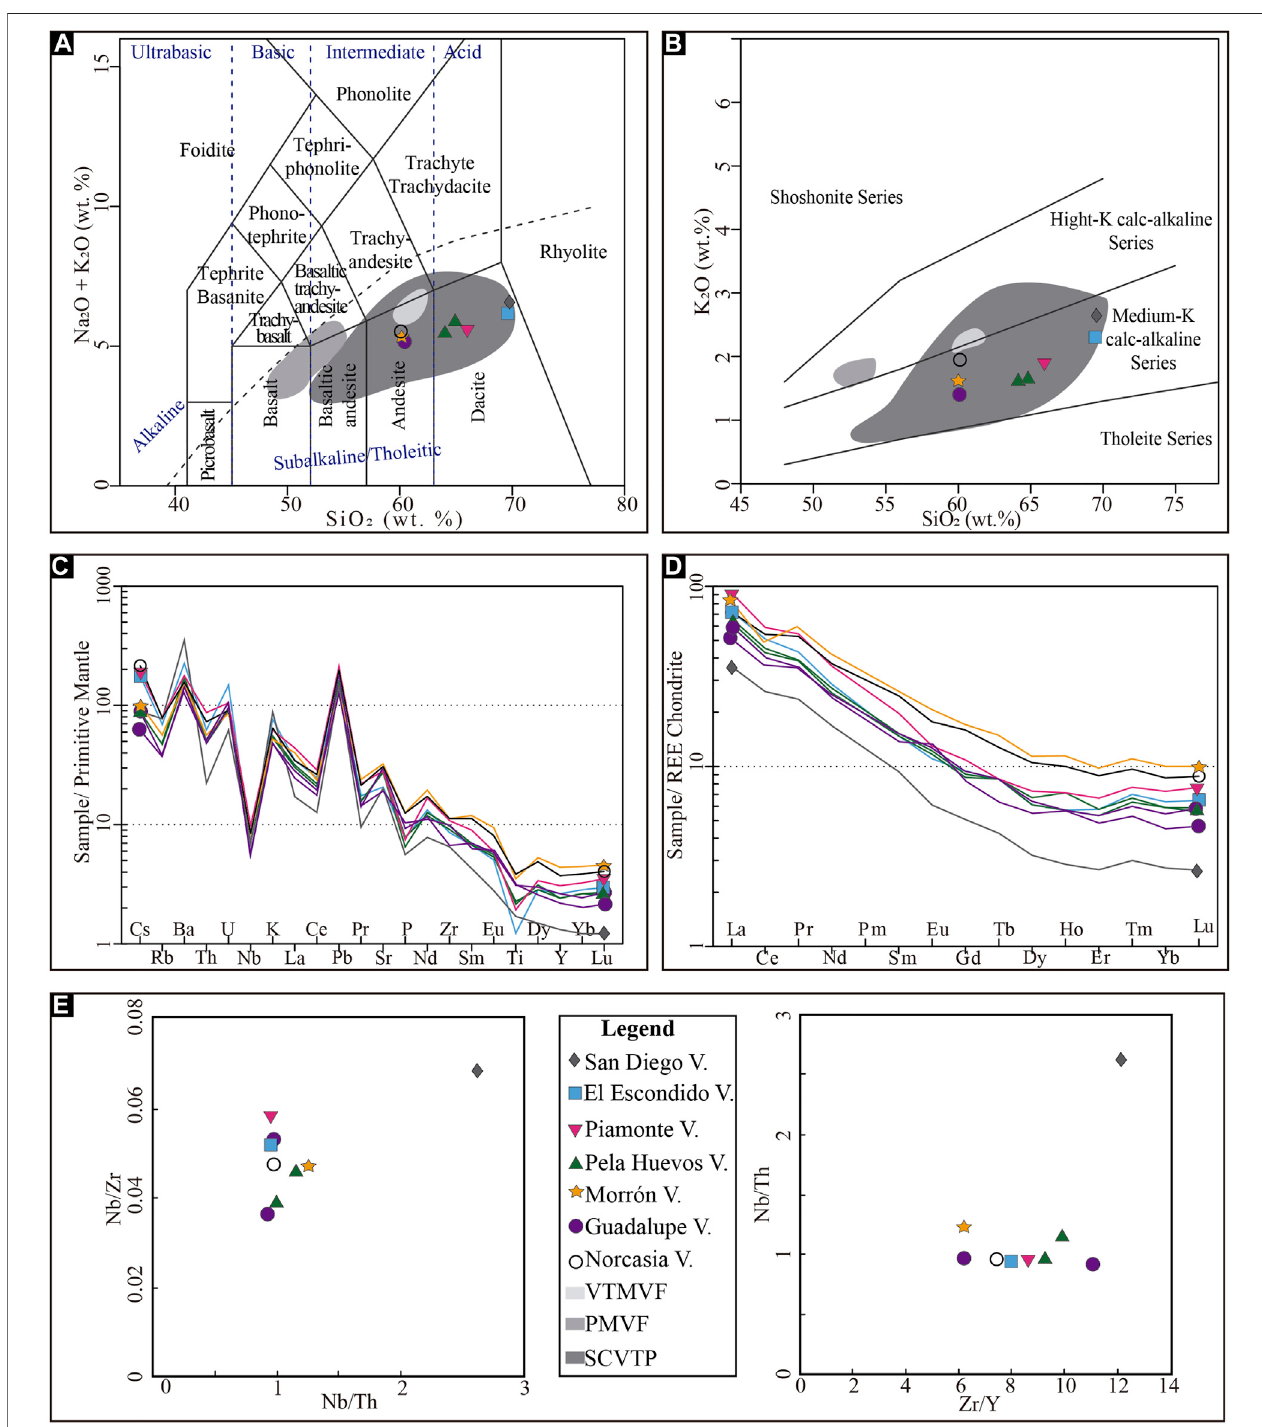
FIGURE 6 | Whole-rock geochemistry diagrams. (A) TAS (Total Alkali Silica) diagram (Le Bast et al., 1986). (B) Magma type classi fi cation diagram (Peccerillo & Taylor, 1976). (C) Multielement diagram normalized to primitive mantle (Sun & McDonough, 1989). (D) REE multielement diagram normalized to chondrite (Nakamura, 1974). (E) Incompatible element ratio diagram. SCVTP, San Diego — Cerro Machín Volcano-Tectonic Province (Cavell, 2020; and references therein); PMVF, Pijaos monogenetic volcanic fi eld (Velandia et al., 2021); and VTMVF, Villamaría – Termales monogenetic volcanic fi eld (Salazar-Muñoz et al., 2021).